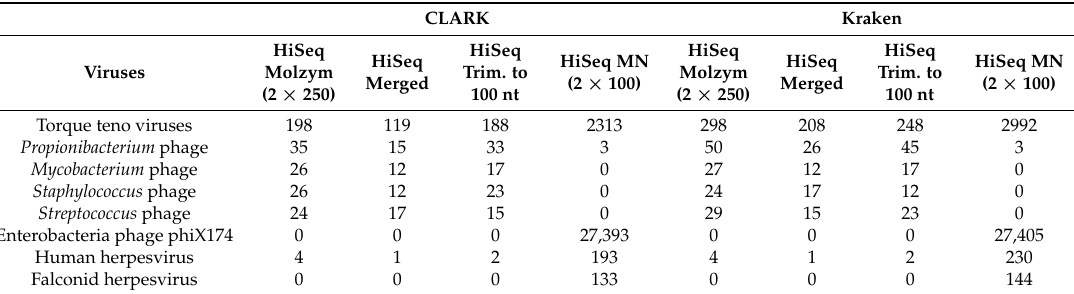
Table 3. Read counts per sample of most abundant